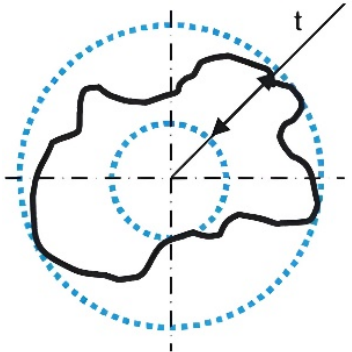
Figure 3. Definition of roundness error.